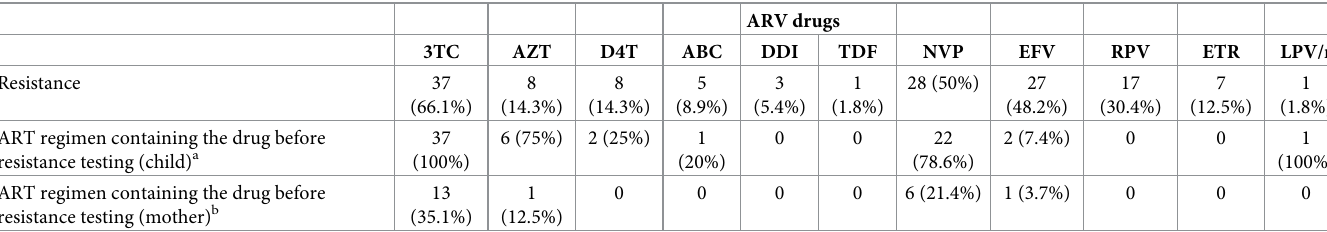
Table 2. History of ART in children with drug